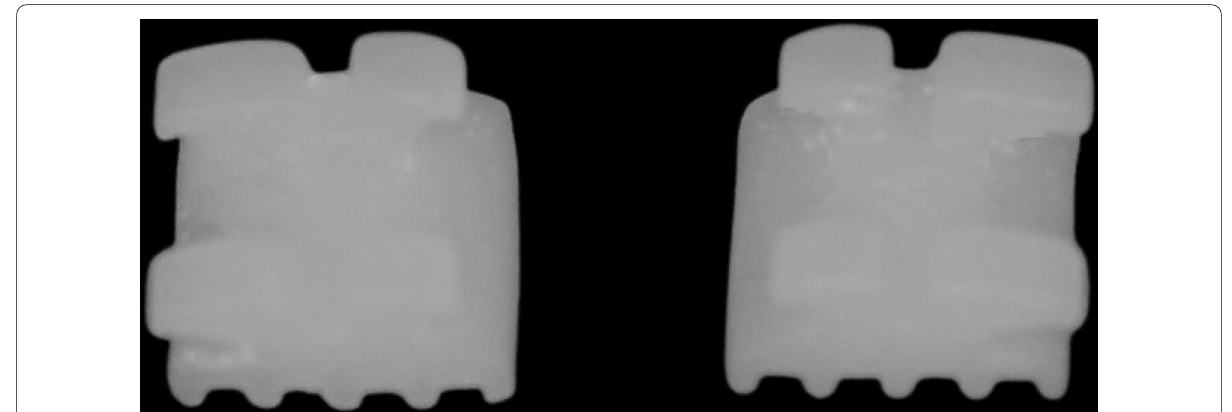
Fig. 1 Prototype resin bracket manufactured by 3D printing